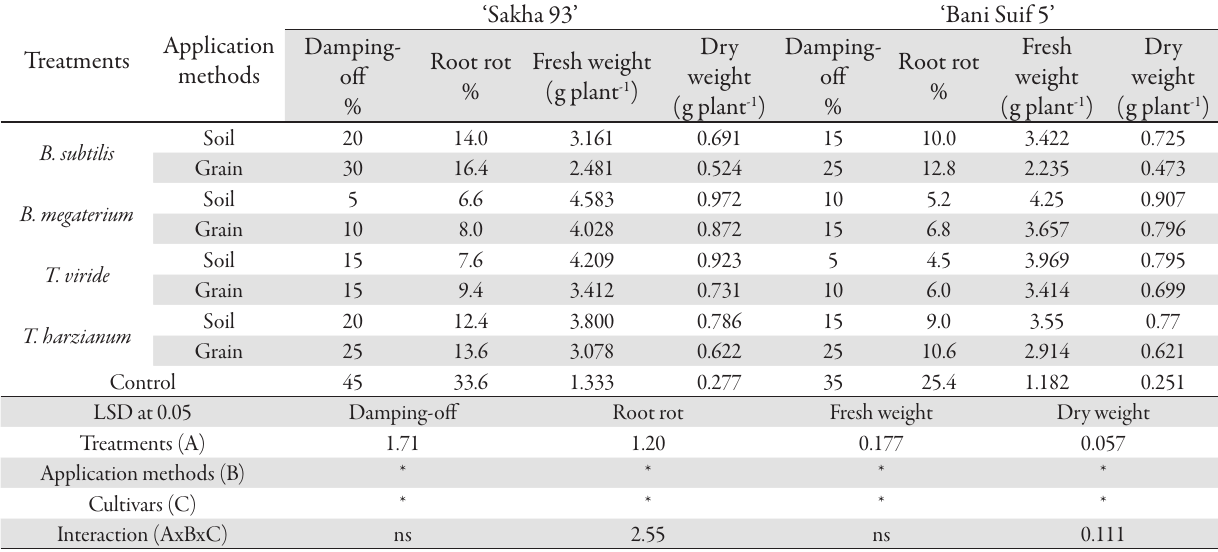
Tab. 4A. Effect of soil drenching, wheat grain treatment with different bioagents on damping-off and root rot diseases, fresh and dry weight plant -1 under artificial infection with Fusarium graminearum under greenhouse conditions